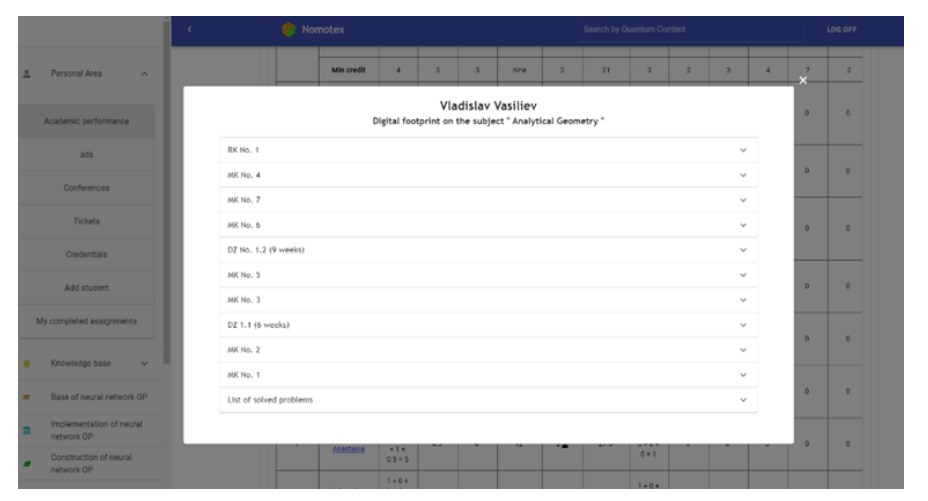
Fig. 5. The data window of control events, which was passed by the student at the Nomotex DLS. Each module is a set of control activities, evaluated in points.